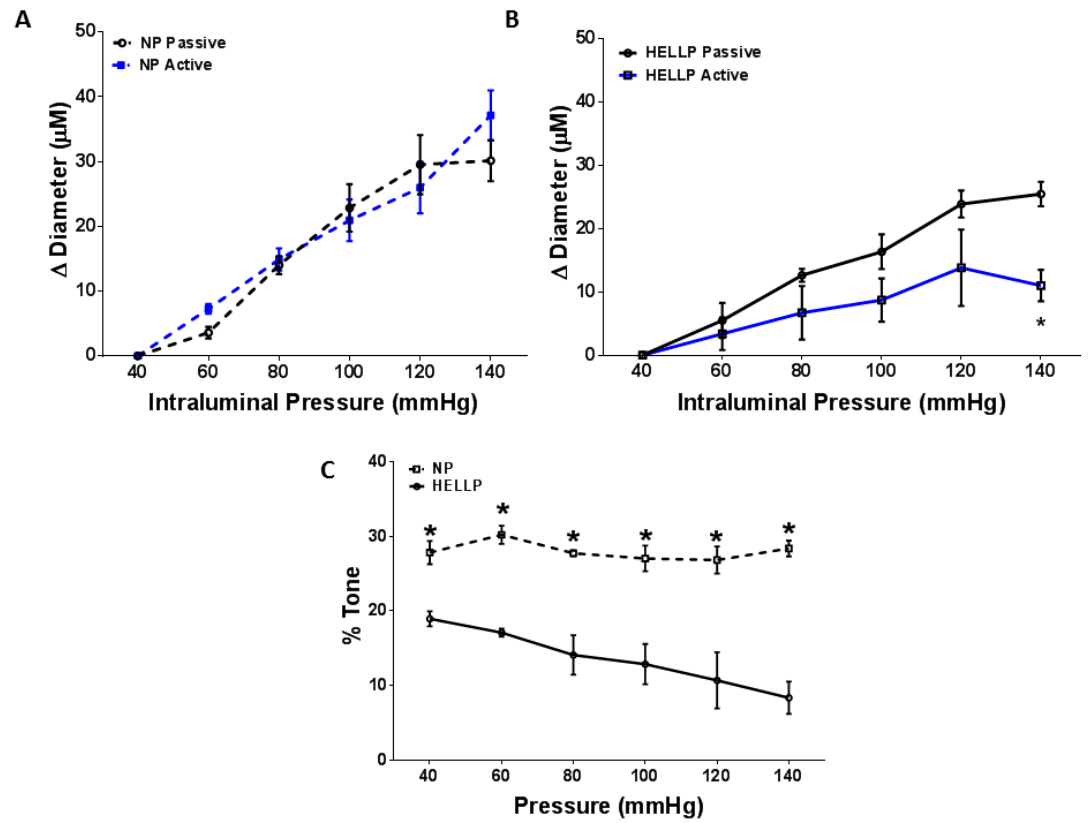
Figure 2. The middle cerebral artery (MCA) was isolated from normal pregnant and HELLP rats, and the relationship in changes to the lumen diameter between the active (with Calcium) and passive (without Calcium) responses was analyzed for NP ( A ) and HELLP ( B ) rats. The myogenic tone of the vessels was calculated and found to be significantly different at all pressures between NP and HELLP rats ( C ). * denotes p < 0.05 compared to the opposite data point at the same pressure. NP, n = 4; HELLP, n = 3.